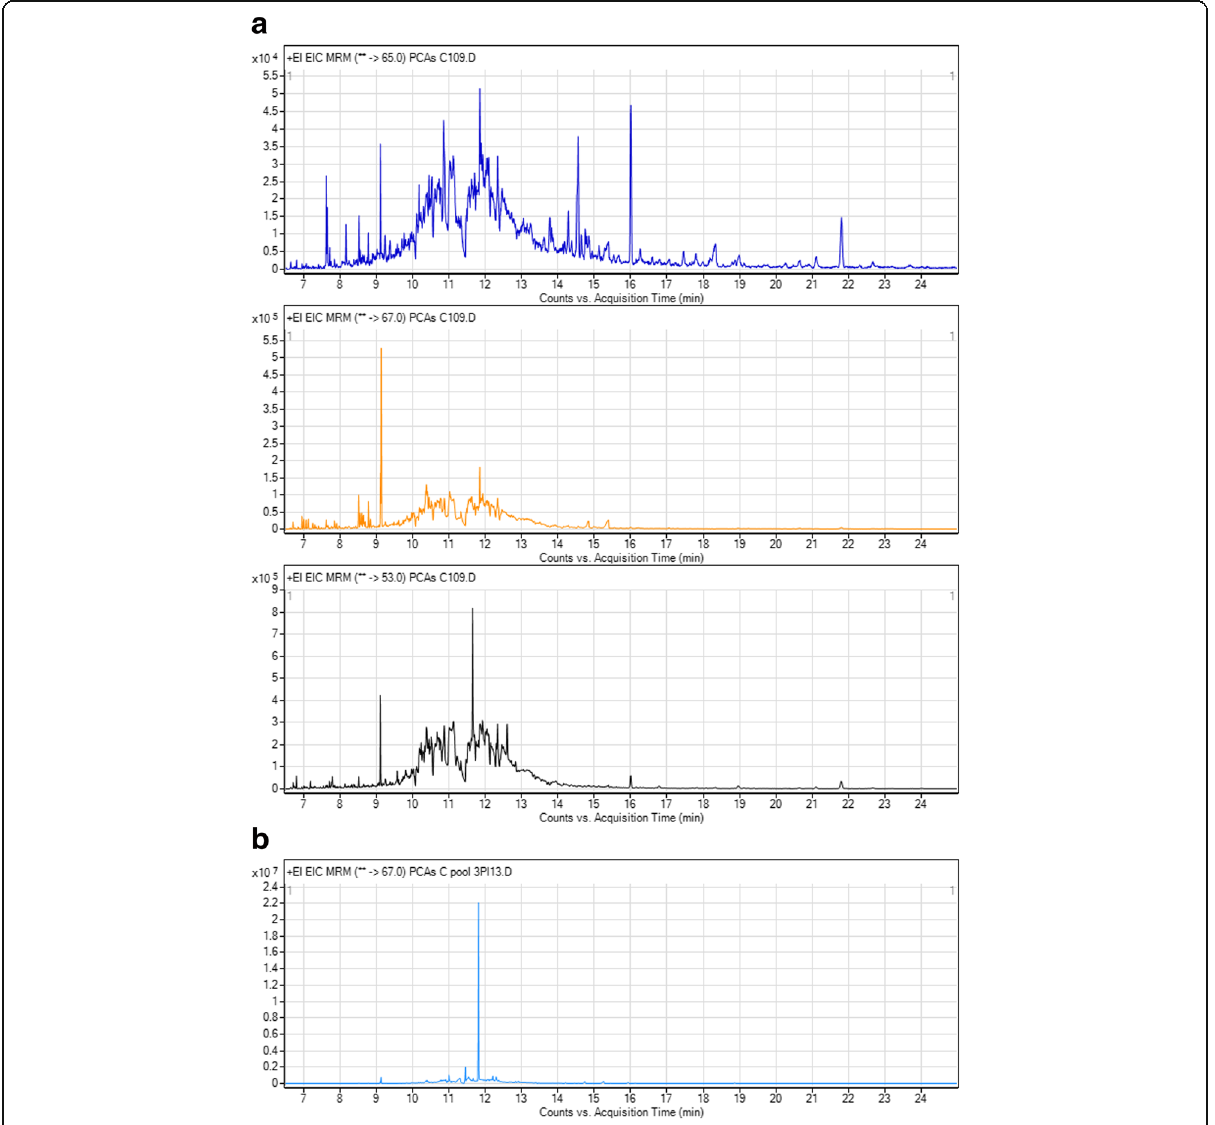
Fig. 4 EIC (extracted ion chromatograms) of SCCPs of an extract of Galician mussel sample (ions 65, 67, and 53) ( a ) and analytical blank (ion 67) ( b